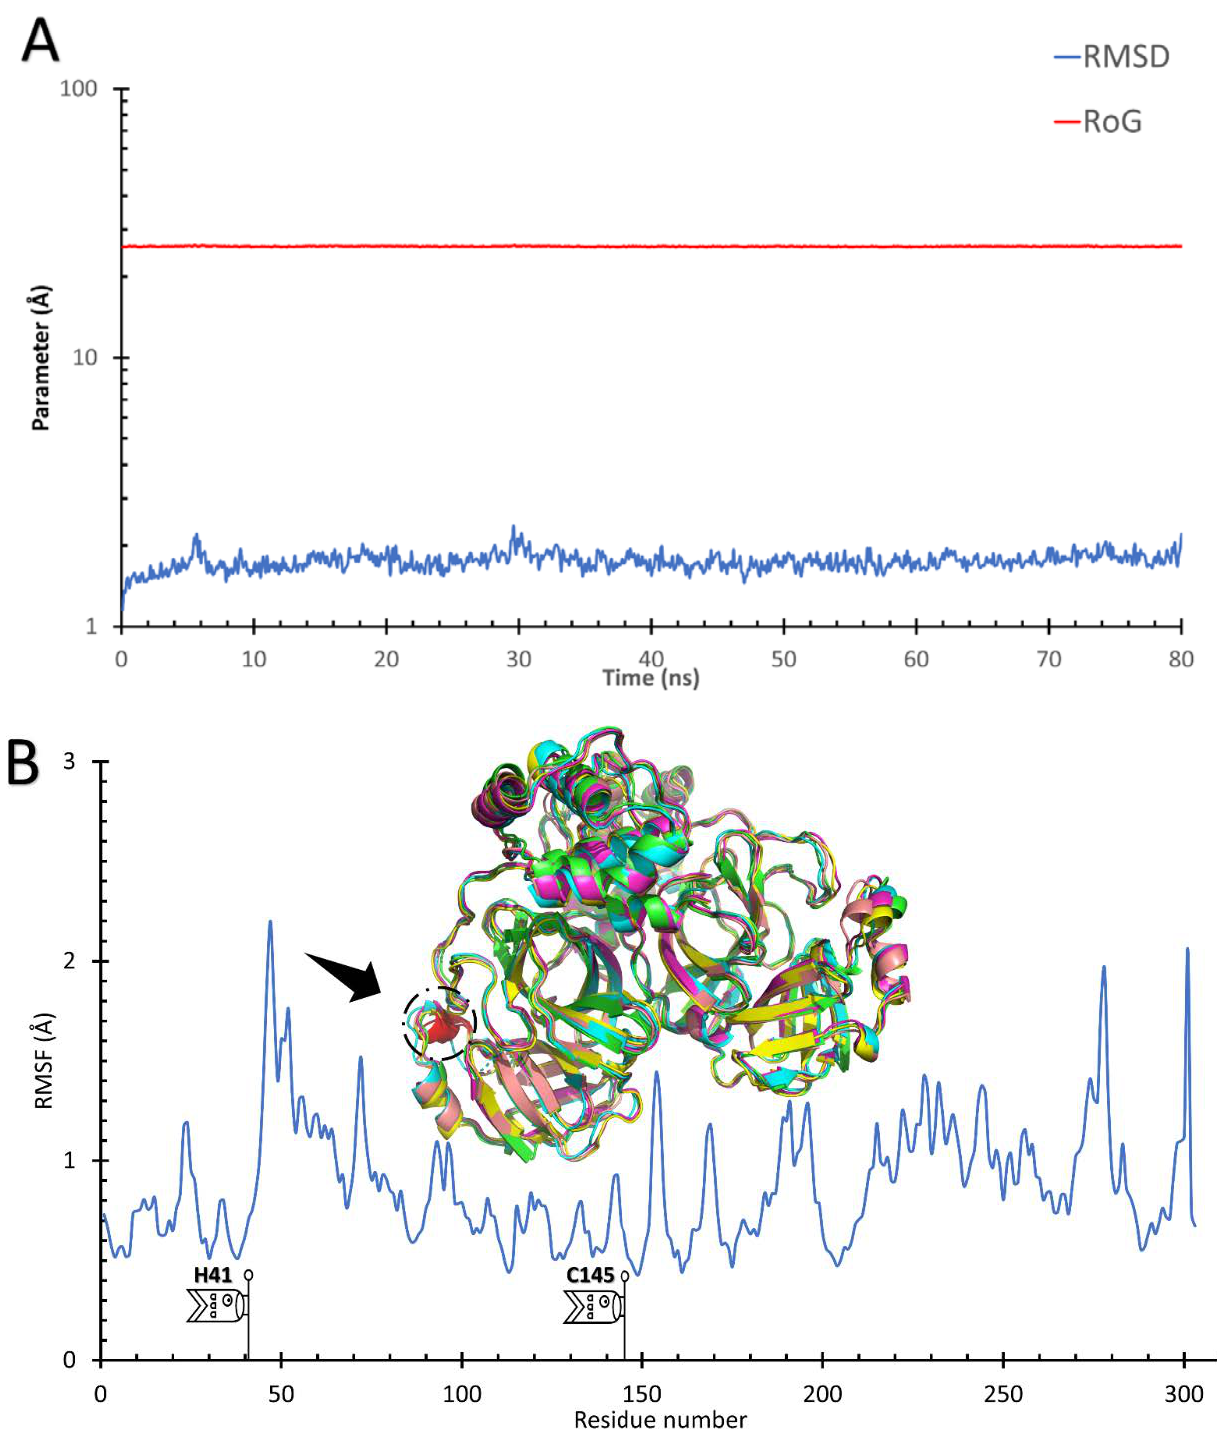
Figure 1. Molecular dynamics simulation analysis. ( A ) The root-mean-square deviation (RMSD) (blue) and the radius of gyration (RoG) (red) versus the simulation time. ( B ) The per-residue root- mean-square fluctuations (RMSF) and the five representative structures of M pro . Active site residues (H41 and C145) are marked on the RMSF curve and the